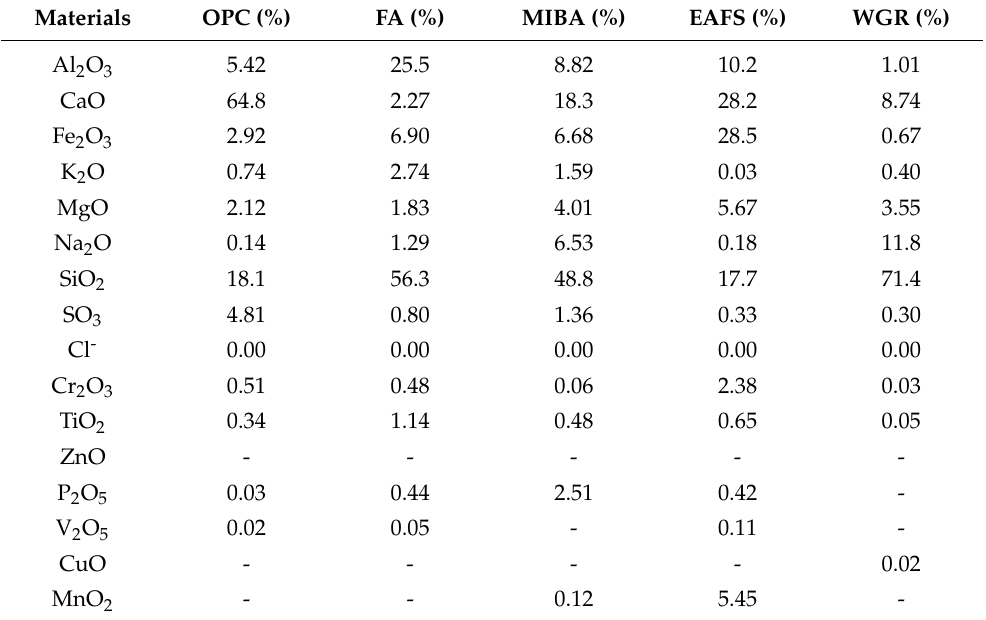
Table 4. Chemical composition of OPC, FA, MIBA, EAFS, and WGR obtained from XRF